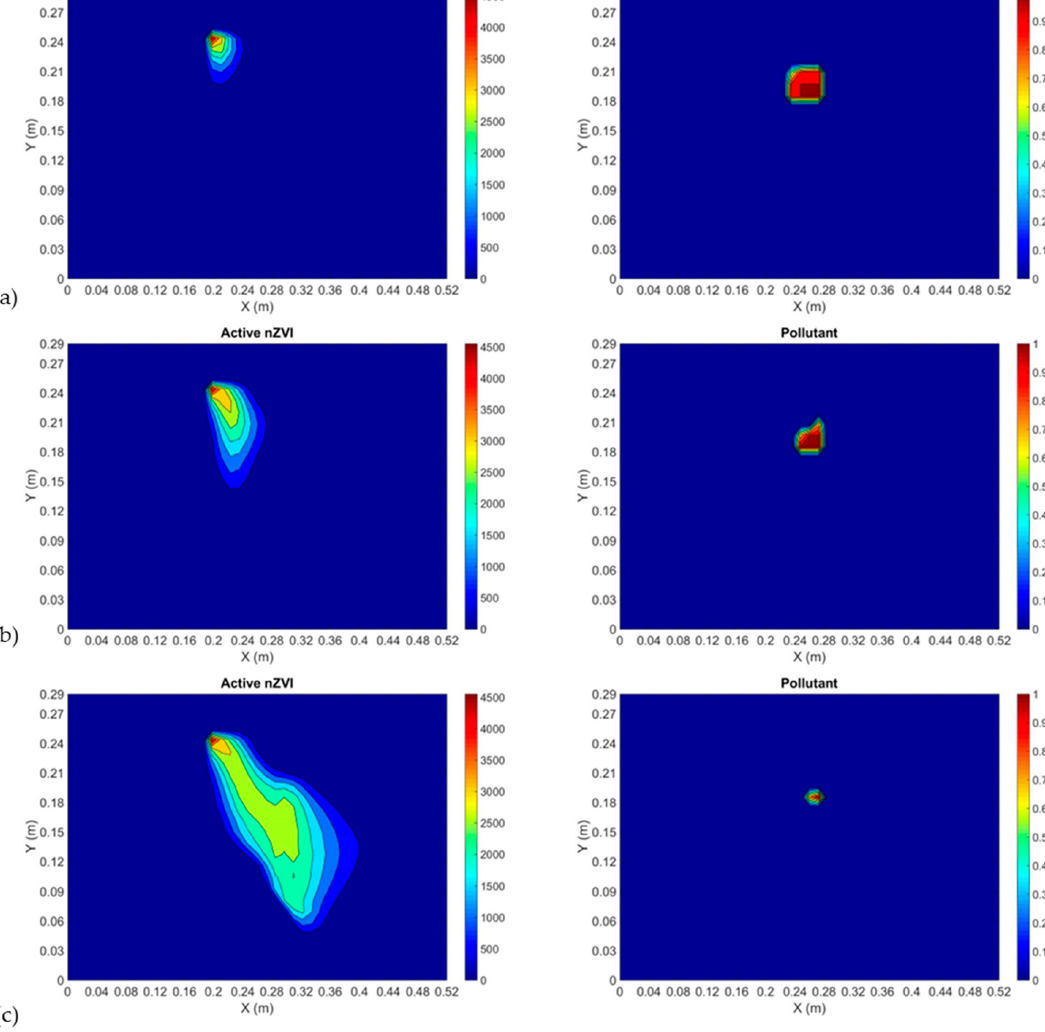
Figure 7. Numerical simulation of nanoparticles redistribution and contaminant removal in a heterogeneous aquifer at time = 46 s ( a ), time = 2 min 11 s ( b ) and time = 2 min 50 s ( c ). The injection of nanoparticles was simulated at P1 .